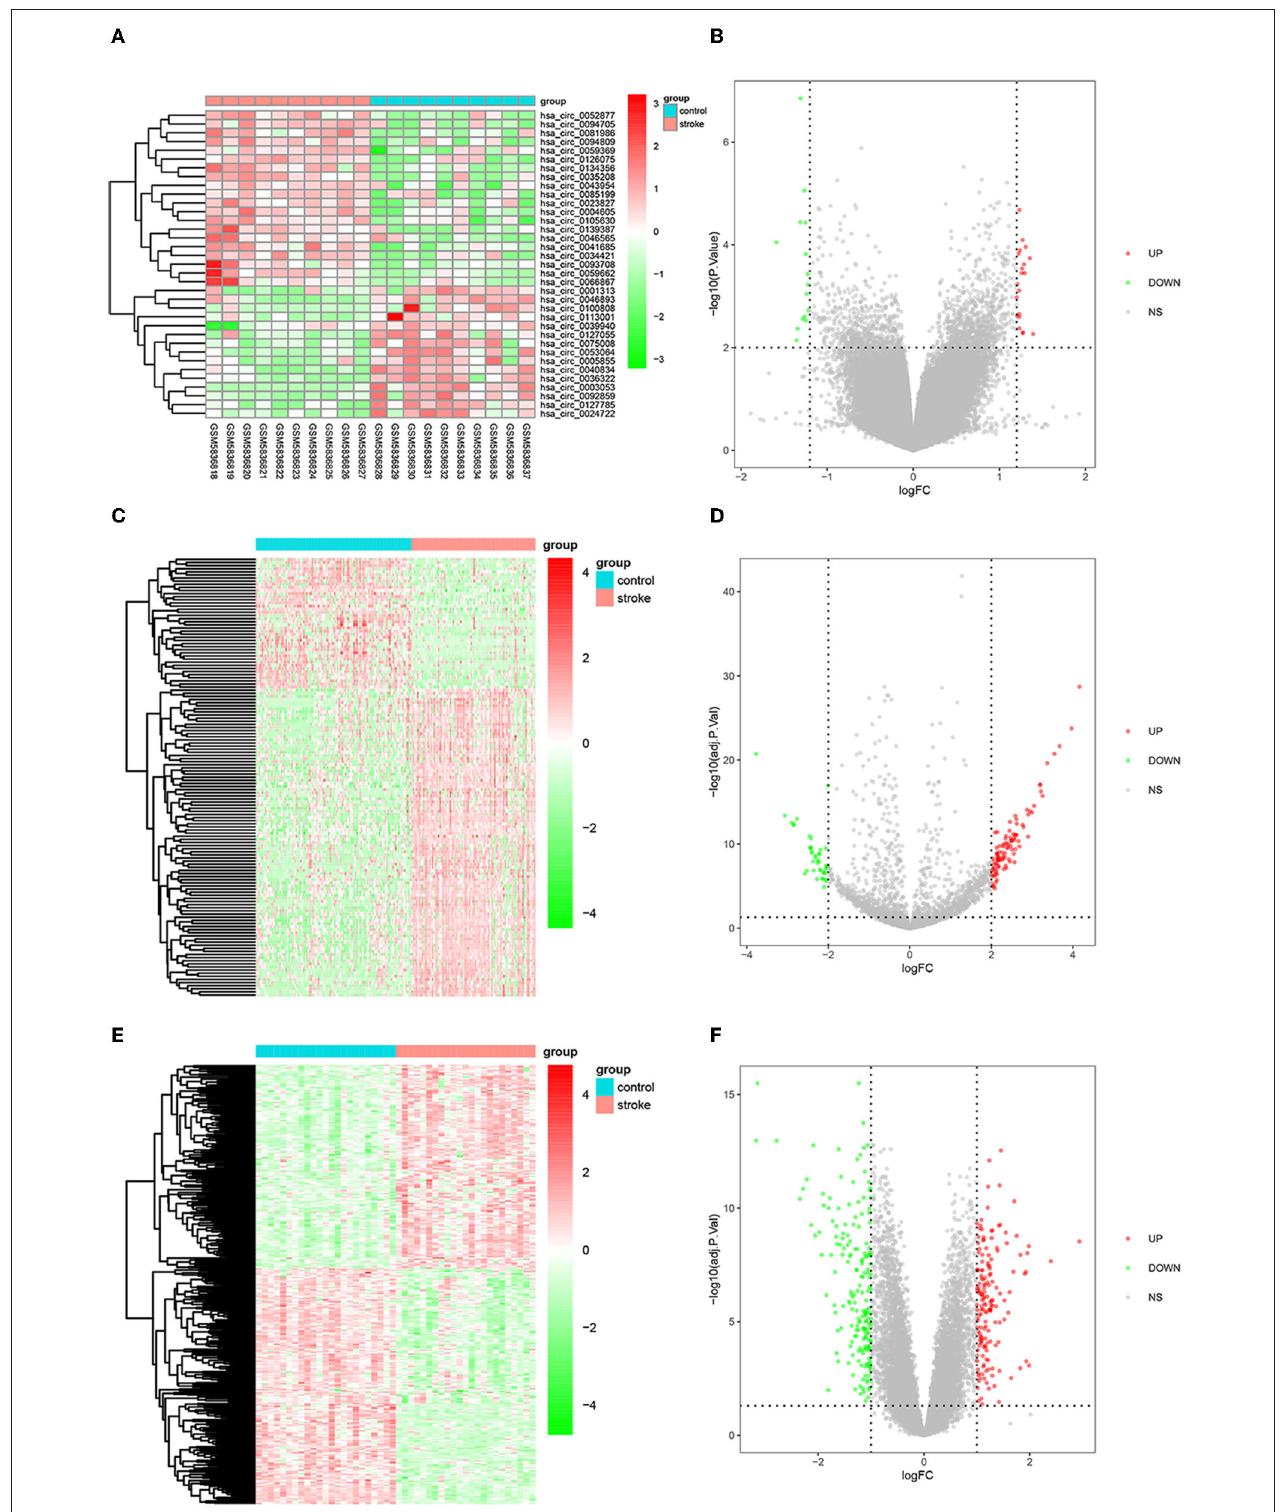
FIGURE 2 | DEcircRNAs, DEmiRNAs, and DEmRNAs in IS. (A) Heatmap and (B) volcano map of DEcircRNAs in the GSE195442 dataset. (C) Heatmap and (D) volcano map of DEmiRNAs in the GSE117064 dataset. (E) Heatmap and (F) volcano map of DEmRNAs in the GSE58294 dataset.